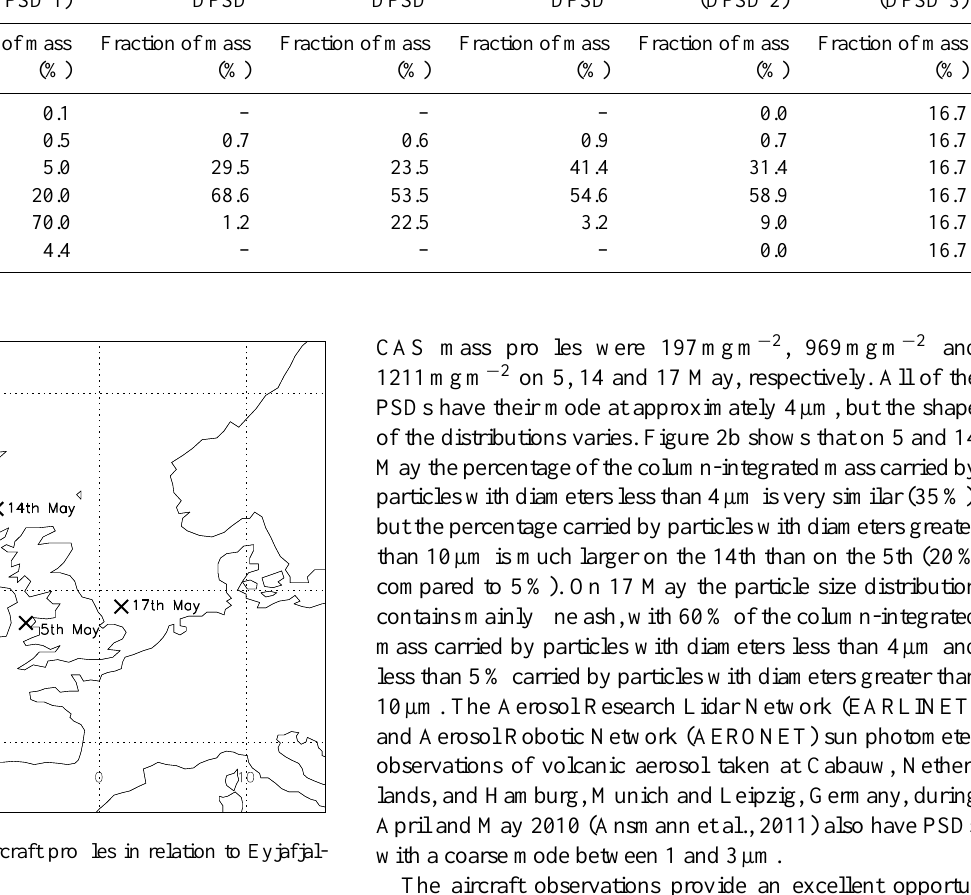
Table 1. distal particle size distributions (DPSD’s). DPSD’s 1, 2 and 3 are used as input to the NAME model. Other DPSD’s are derived from observations on the 5 th, 14 th and 17 May. Original